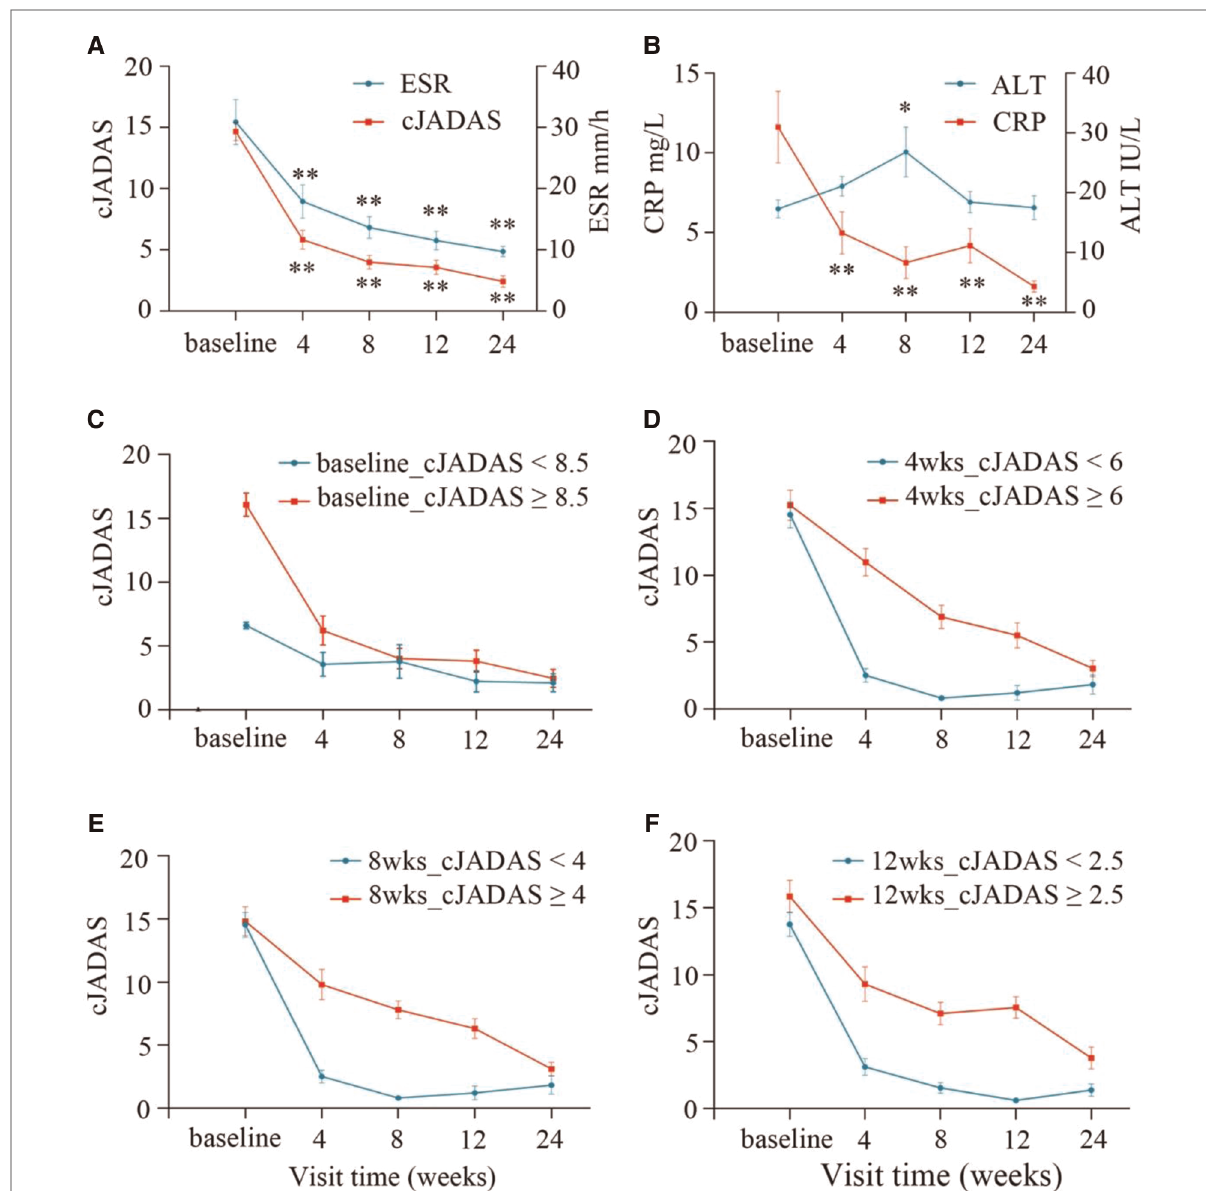
FIGURE 2 Clinical response at baseline and after 4, 8, 12, 24 weeks of rhTNFR-Fc therapy. ( A ) The cJADAS-10 sharply decreased from 14.66 at the baseline to 5.81 at 4 weeks ( P <0.001), and the cJADAS-10 decline slowly from 3.97 to 2.40 at 8 weeks and 24 weeks; the similar trend exists in ESR. ( B ) The decreased trend was observed in CRP; ALT were within normal ranges with moderately elevation at week 8. The similar trend to the total cJADAS-10 ( A ) was showed in various cJADAS-10 subgroups based on the baseline ( C ), and mean cJADAS-10 of 4 ( D ), 8 ( E ), and 12 ( F ) weeks after treatment ( P <0.01). cJADAS, clinical Juvenile Arthritis Disease Activity Score; ESR, erythrocyte sedimentation rate; CRP, C reactive